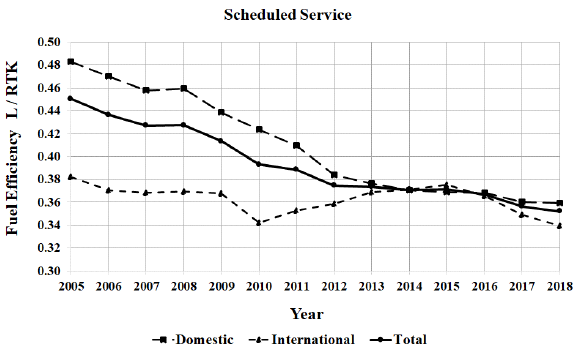
Figure 3. Domestic, international, and total Fuel Efficiency Values (Litres/RTK) for non-scheduled U.S. air carriers on